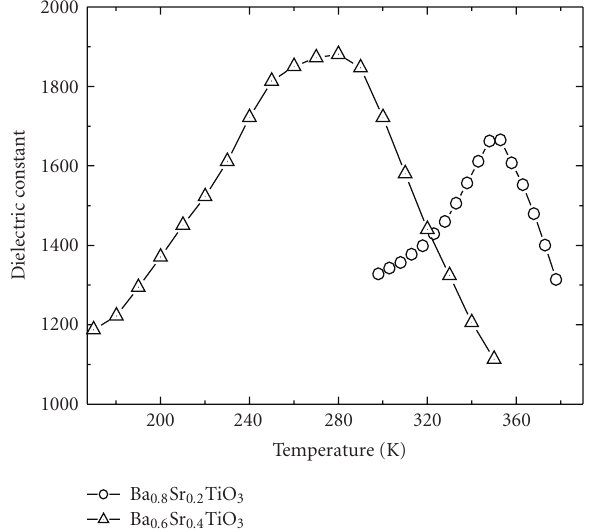
Figure 3: Temperature dependence of the dielectric constant of the sintered BST(0.2) and BST(0.4)